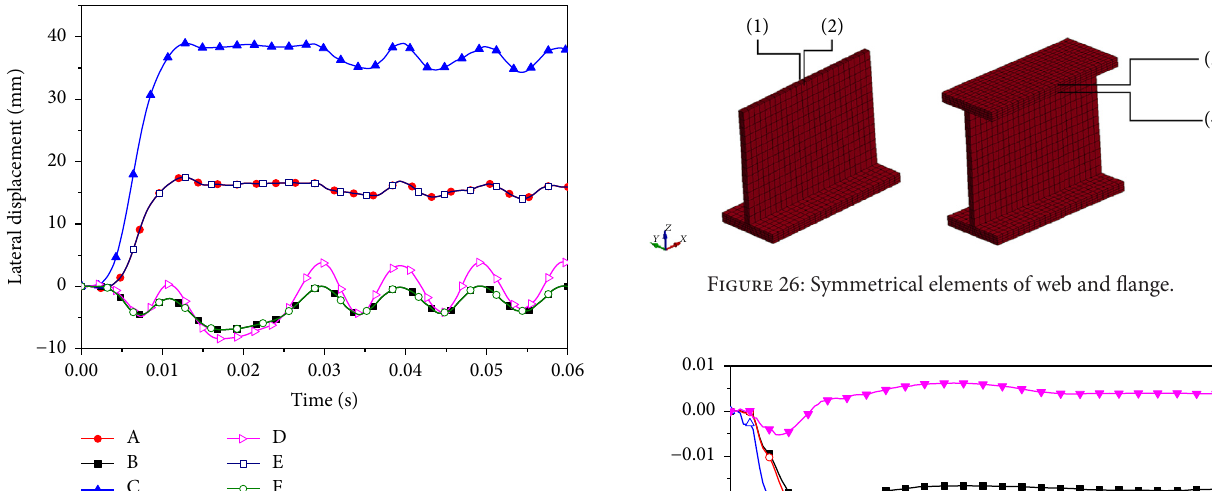
Figure 24: Lateral displacement–time history curve.